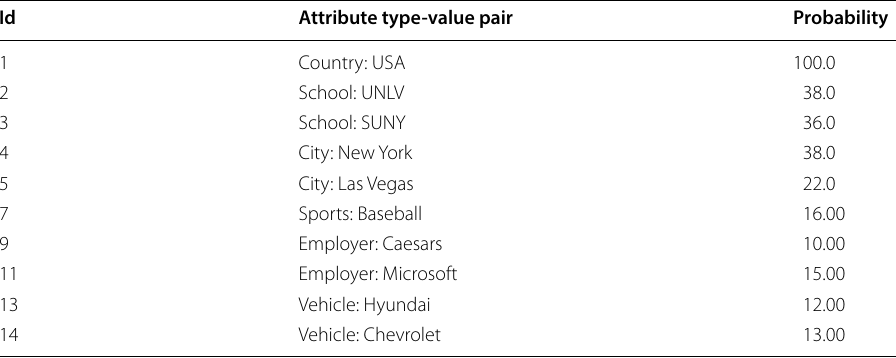
Table 4 Edge-weight for Karate-club